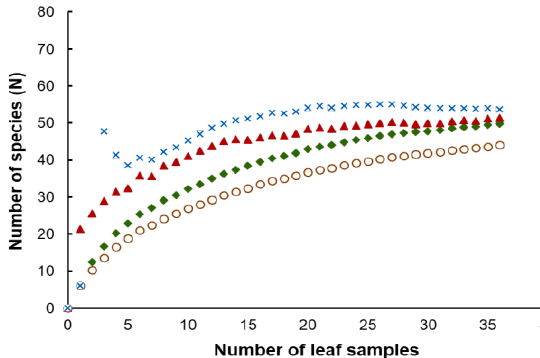
Figure 5. Observed (unfilled circle) curves and estimated phylotype richness of corn phylloplane yeast versus sample size using bootstrap (filled diamond), Chao 1 (filled triangle) and ICE (cross) estimators using sample-based abundance data.